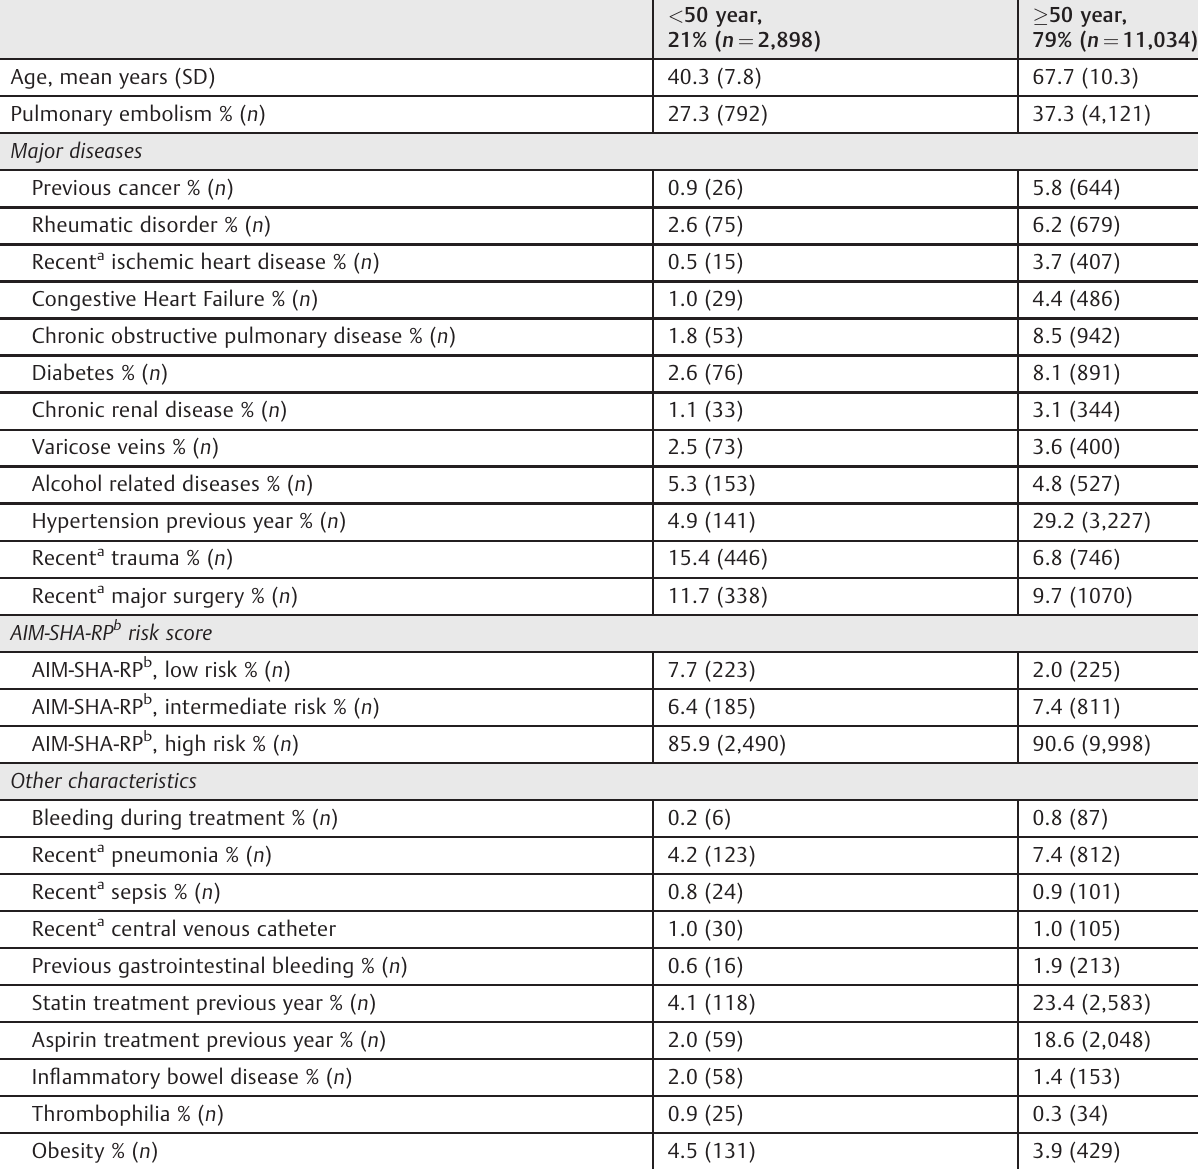
Table 1 Baseline characteristics of 13,932 men with incident